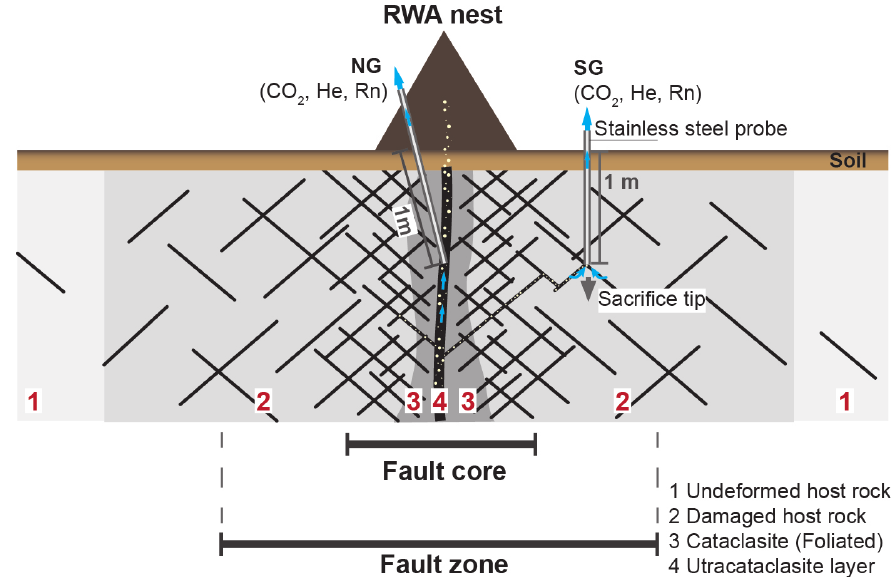
Figure 1. Schematic diagram (not to scale) showing the basic structural elements of a principal fault zone with a red wood ant (RWA) nest (brown triangle) and exemplar nest gas (NG) and soil gas (SG) probes (not to scale). Yellow bubbles indicate gases migrating upward through the fault network. Variation in structure along and between faults is common; damage intensity and thickness of the damaged zone vary laterally towards the core zone. Depending on positions of SG probes within the damaged zone, fluid flow and degassing may be limited (modified after